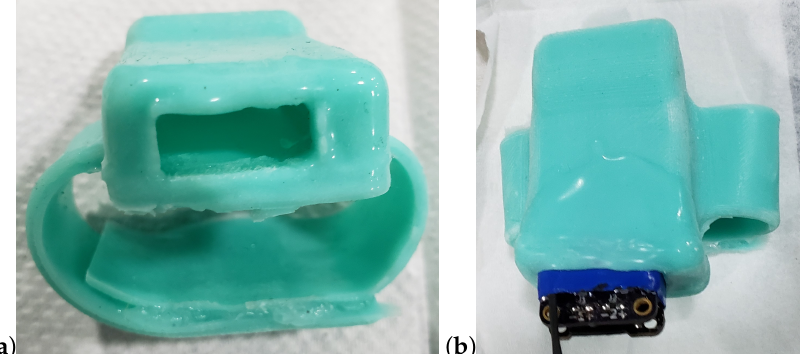
Figure 8. Watch-band type enclosure shown ( a ) with opening to insert the device, and ( b ) the partially inserted device, ready to solder the